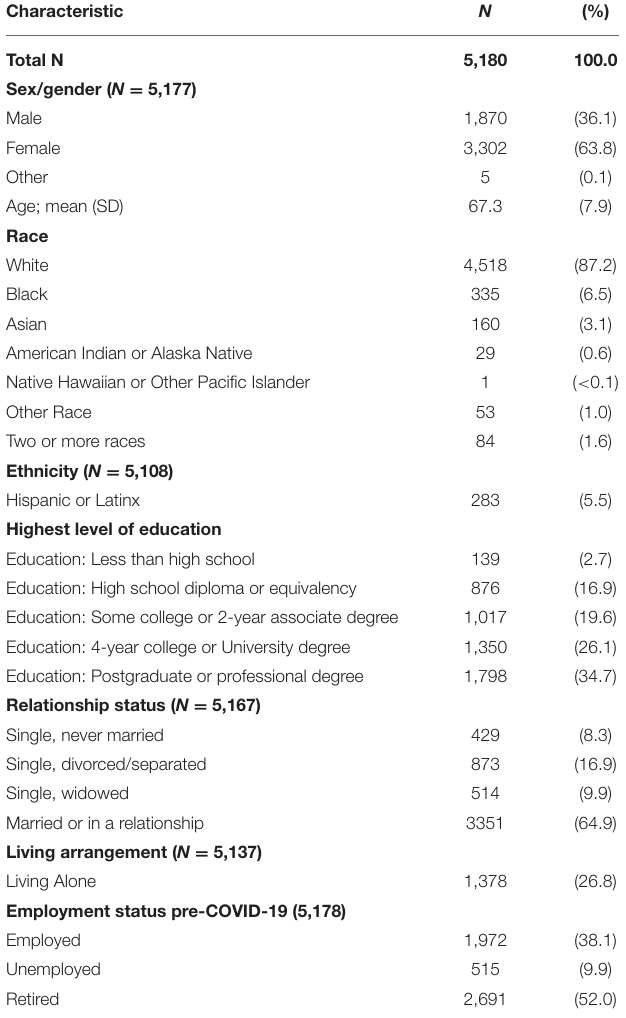
TABLE 1 | Baseline characteristics of the sample, COVID-19 Coping Study, 2020.